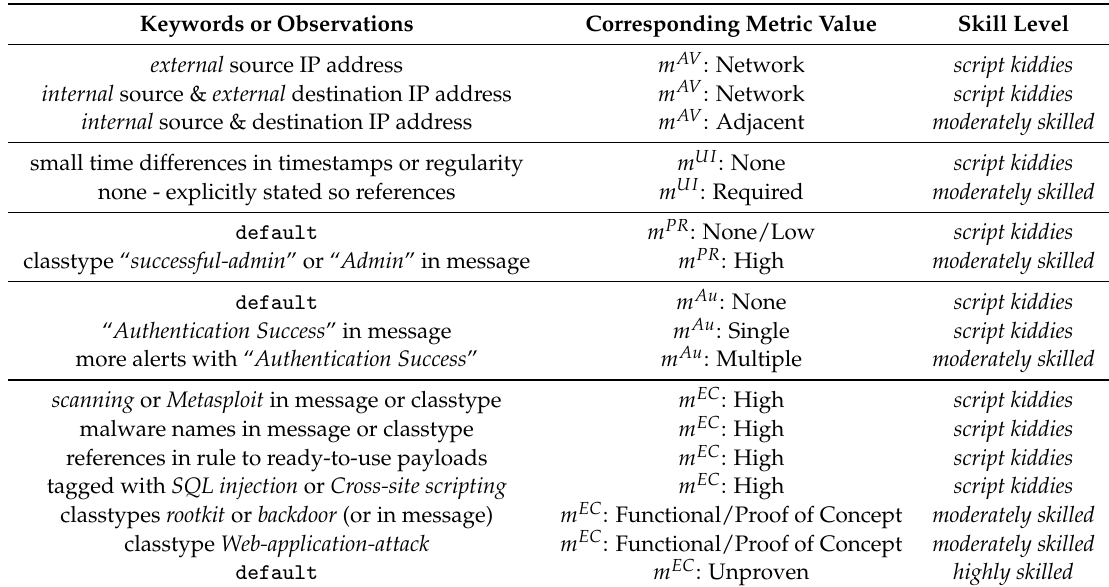
Table 1. Keywords or observations that distinguish skill level